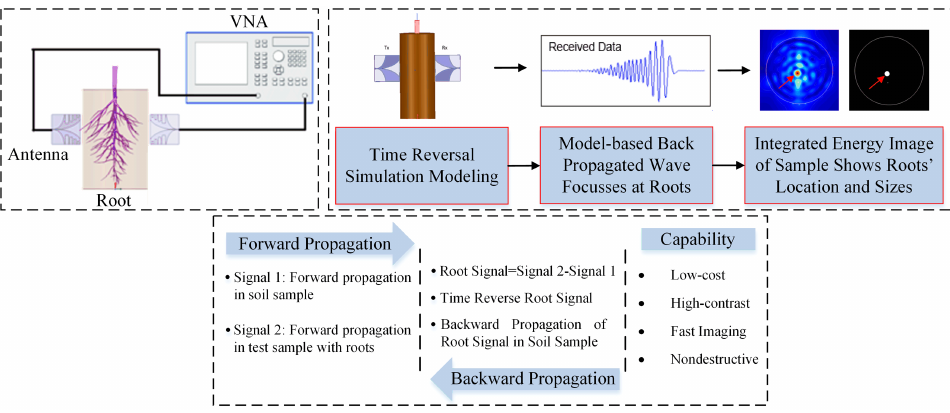
Figure 1. Flow chart of the root imaging technique using time